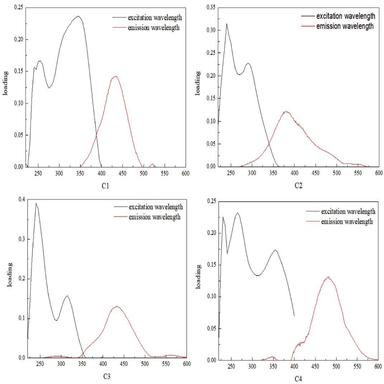
Ex/Em loading of deconvoluted PARAFAC components (C1- C4).